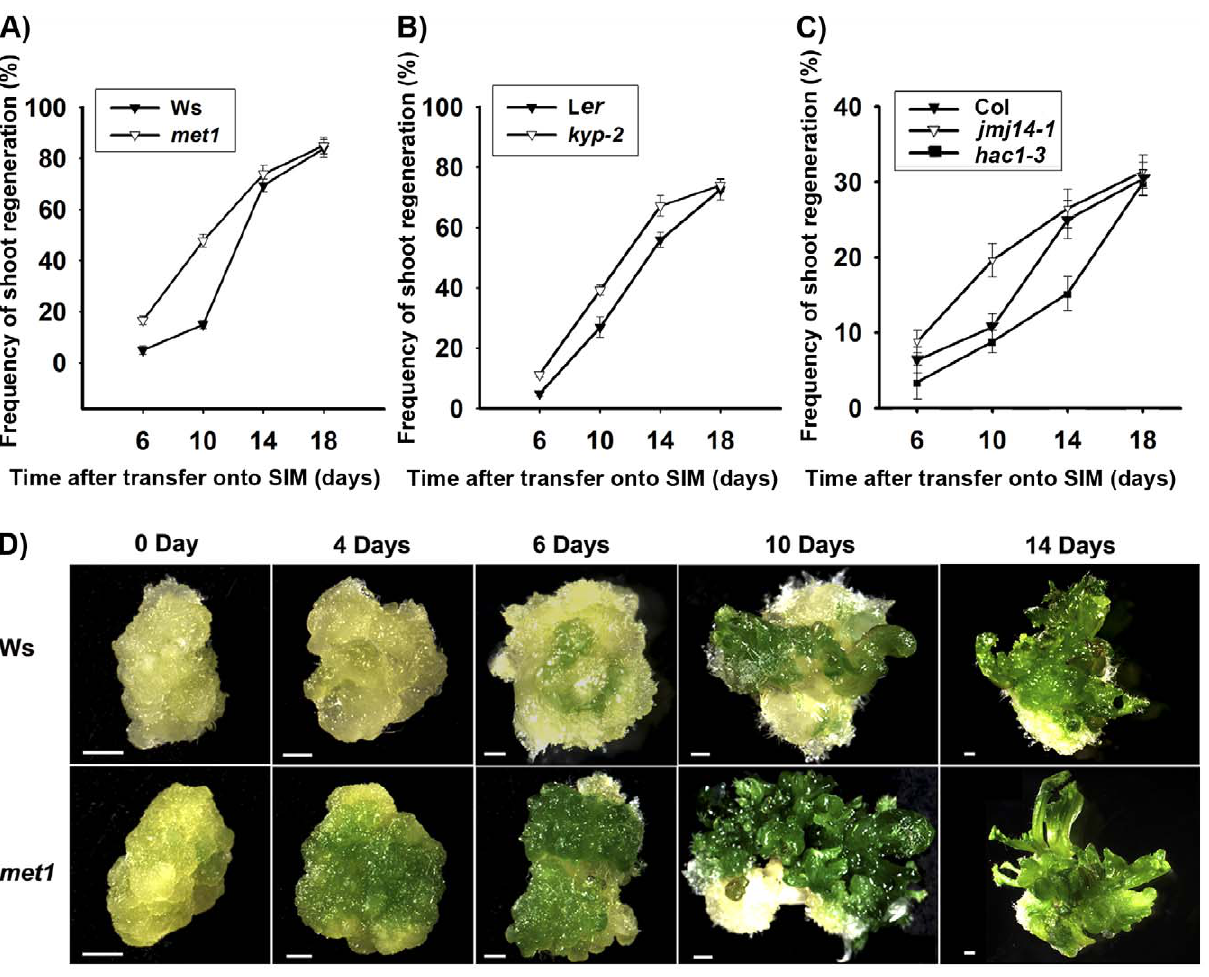
Figure 1. Mutation in key epigenetic genes alters the rate of Arabidopsis shoot regeneration invitro . A) Frequency of shoot regeneration from calli of the wild type (Ws) and the mutant met1 . B) Frequency of shoot regeneration from calli of the wild type (L er ) and the mutant kyp-2 . C) Frequency of shoot regeneration from calli of the wild type (Col) and the mutants jmj14-1 and hac1-3 . Calli were induced from pistils on CIM, and were then transferred onto SIM for shoot induction. Data are presented as mean values from three sets of biological replicates. In each replicate, at least 60 calli were examined. D) Calli of the wild type (Ws) and the mutant met1 cultured on SIM for 0 day, 4 days, 6 days, 10 days and 14 days. Scale bars, 1